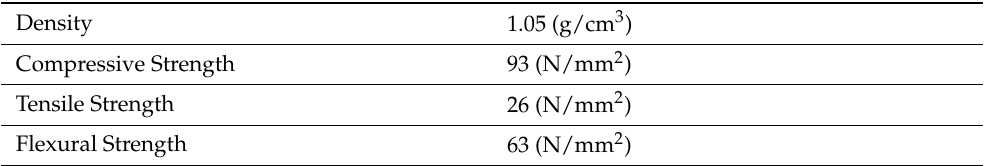
Table 1. The properties of used epoxy resin.